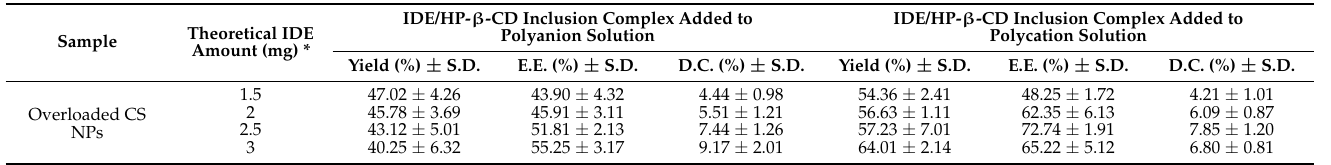
Table 3. Yield percentage, encapsulation efficiency (E.E.), and drug content (D.C.) of CS NPs prepared using the IDE/SBE- β -CD inclusion complex (1:2 molar ratio) as a gelling agent and overloaded with different concentrations of the IDE/HP- β -CD inclusion complex (1:2 molar ratio) (overloaded CS NPs). The values are expressed as the mean of six batches ± standard deviation